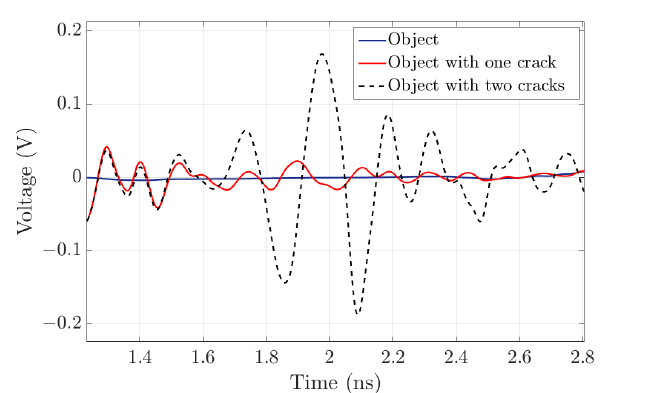
Figure 5. Comparison between the reflected voltage in the three different rectangular cuboid objects